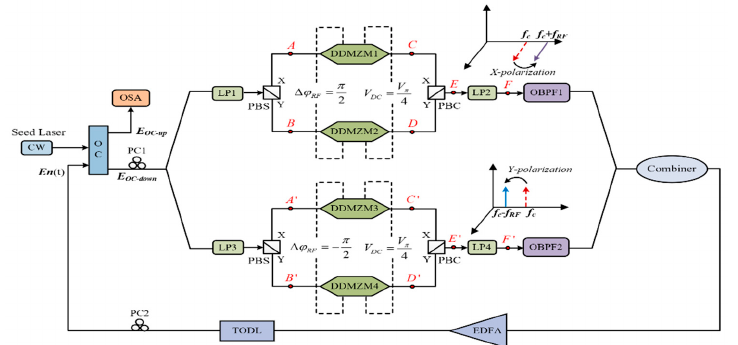
Figure 1. Basic structure of the proposed OFC generation system. CW—continuous-wave laser; PC—polarization controller; LP—linear polarizer; PBS—polarization beam splitter; DDMZM—dual-drive Mach–Zehnder modulator; PBC—polarization beam combiner; OBPF—optical band-pass filter; EDFA—erbium doped fiber amplifier; TODL—tunable optical delay line; OSA—optical signal analyzer.